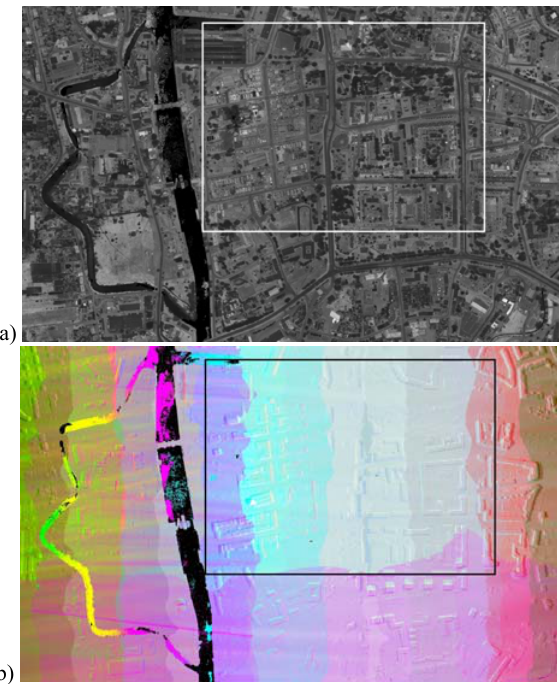
Figure 1. Test area – part of Old Town in Elbl ą g, Poland: intensity image of LIDAR (a) and its scanning strips (b) Parameter average residual